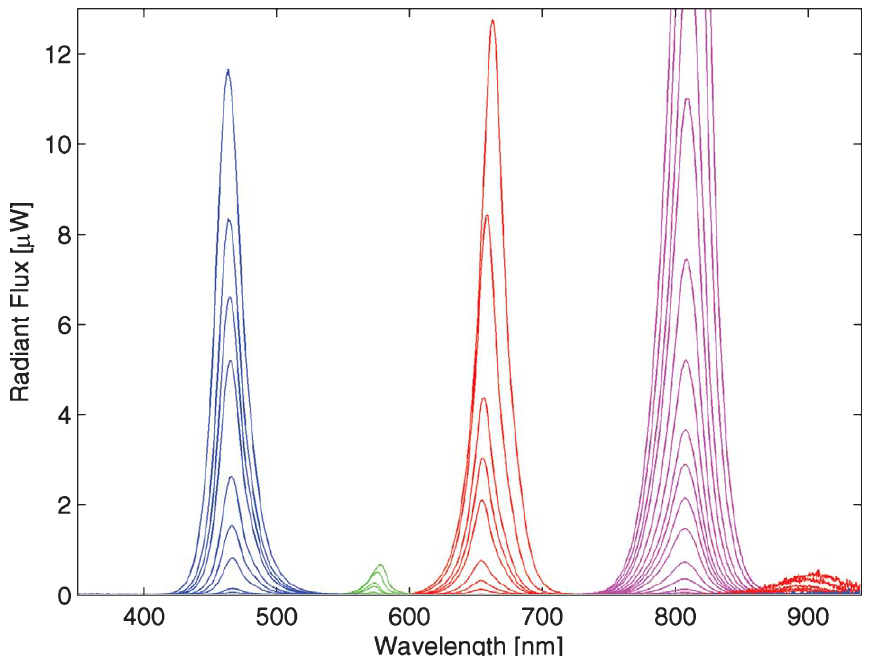
Fig. 11. Spectral radiant flux over a range of LED forward currents. The larger forward currents result in taller and wider peaks. The center wavelengths are 468nm (blue), 574nm (green), 660nm (red), and 810nm (infrared). The green LED has significantly lower radiant flux than the others, and the red LED has a small, secondary emission centered at 900nm.